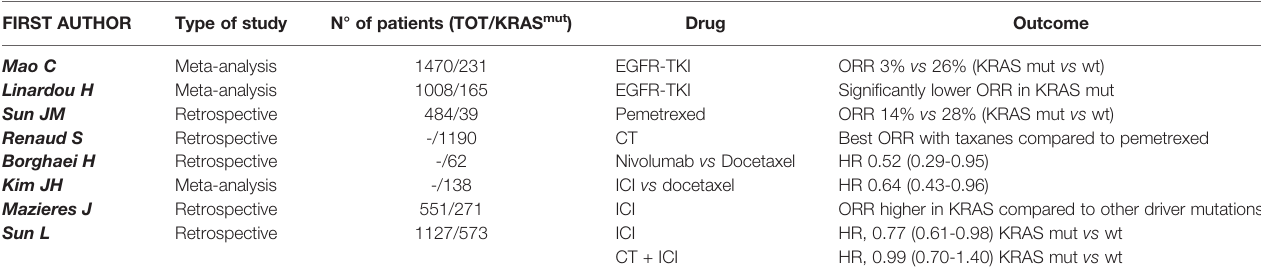
TABLE 2 | Trials evaluating KRAS as a potential predictive marker.